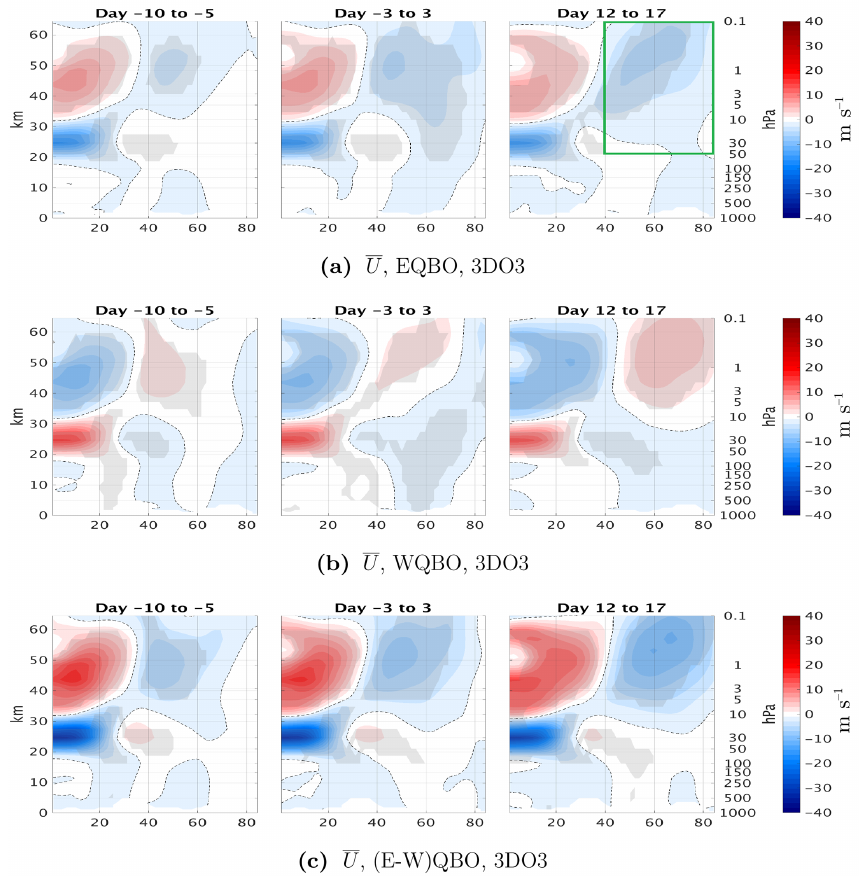
Figure 6. Time lag composite of the zonal mean zonal wind anomalies for east QBO (a) , west QBO (b) , and the difference between them (c) for the positive heat flux events from the 3DO 3 run of October. The green box in row (a) shows the area of averaging for Fig.